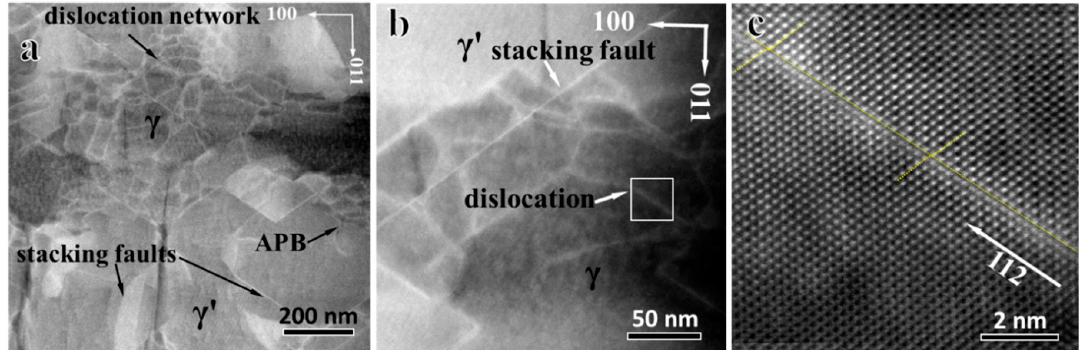
Figure 2. ( a ) HAADF image on typical defect viewed along the <011> direction. ( b ) HAADF images on a dislocation network located in the γ phase adjacent to the γ / γ ' boundary and ( c ) its enlarged part of dislocation (square in b). Two yellow dashed lines were indexed on the shift of atomic planes across the dislocation.